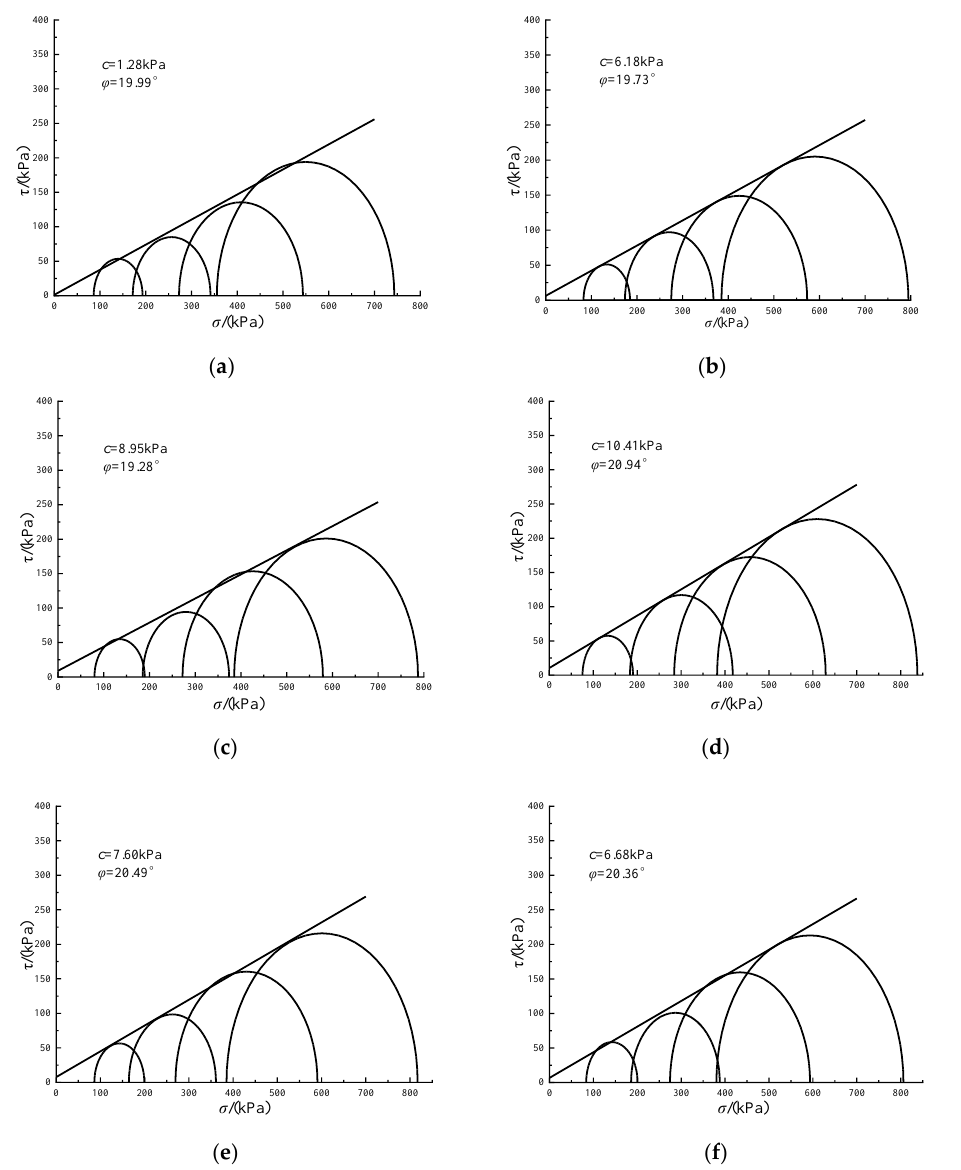
Figure 7. Mohr–Coulomb strength envelope of soil samples. ( a ) 0% coir fiber; ( b ) 0.2% coir fiber; ( c ) 0.25% coir fiber; ( d ) 0.3% coir fiber; ( e ) 0.35% coir fiber; ( f ) 0.4% coir fiber. Table 2. Shear strength index of samples.